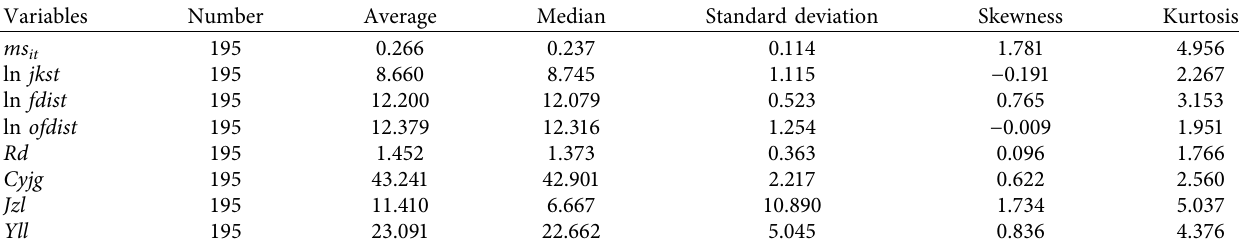
Table 1: The descriptive statistics of variables.